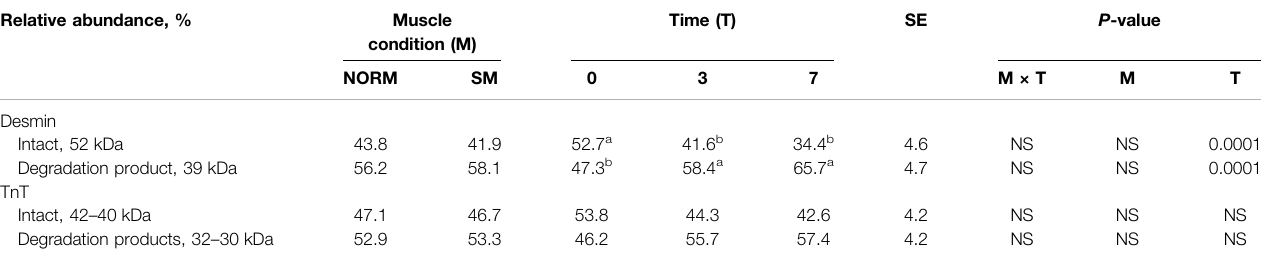
TABLE3| WesternBlotdatafordesminandtroponin-Tofbroilerbreastmeataccordingtomusclecondition(M — normal,NORM;SpaghettiMeat,SM)andpostmortemtime (T — 0, 3, 7 days). Relative abundance,